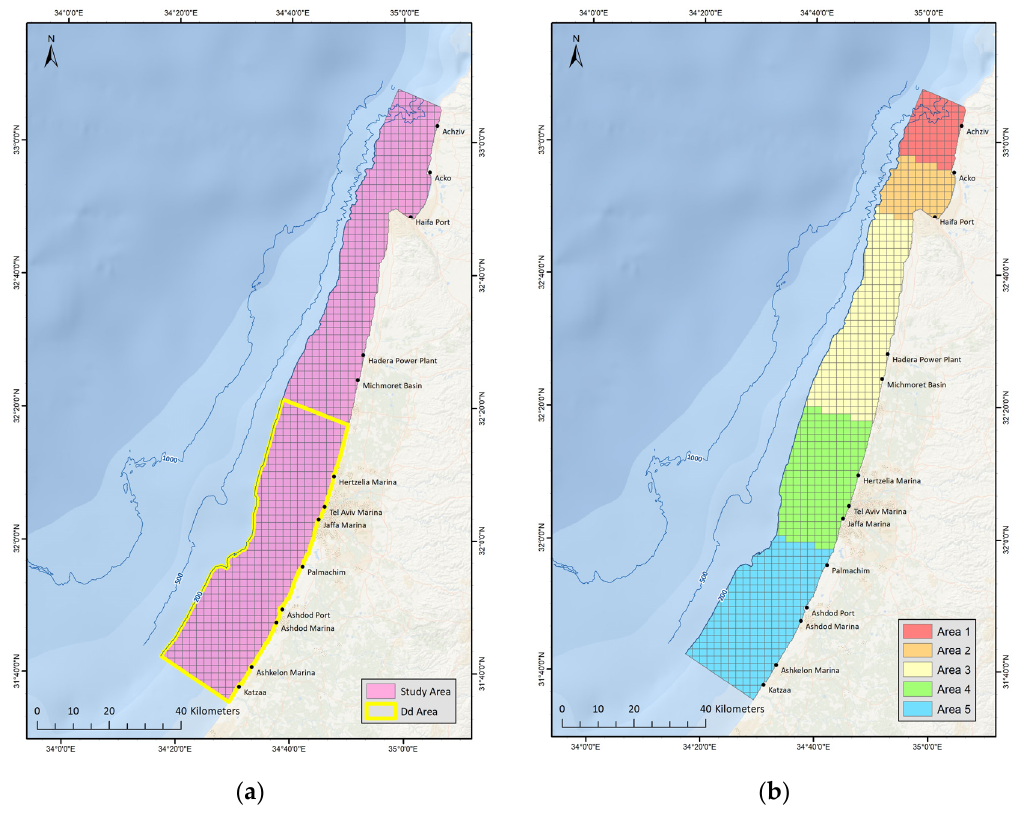
Figure 1. ( a ) A 2 × 2 km gridded map of the study area. Section outlined in yellow indicates the ‘Dd Area’ in the south. Displayed also are the 200 m, 500 m and 1000 m isobars; ( b ) Map displaying division of the continental shelf into 5 spatial subsets.